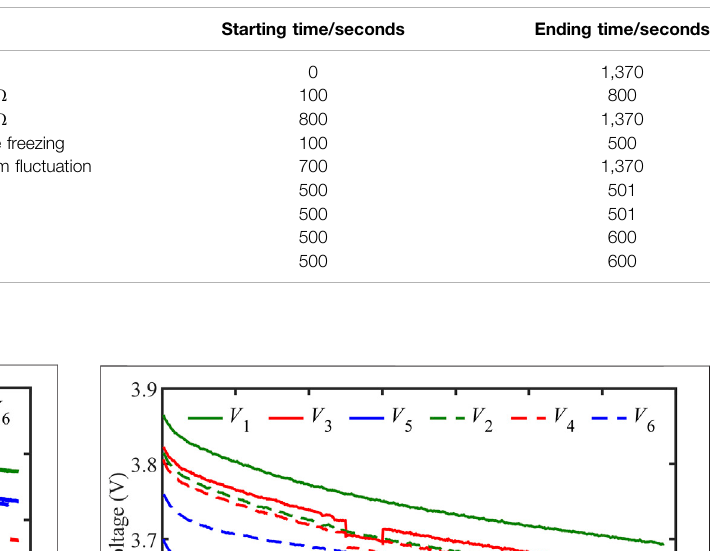
TABLE 1 | Details of the equivalent fault experiment.